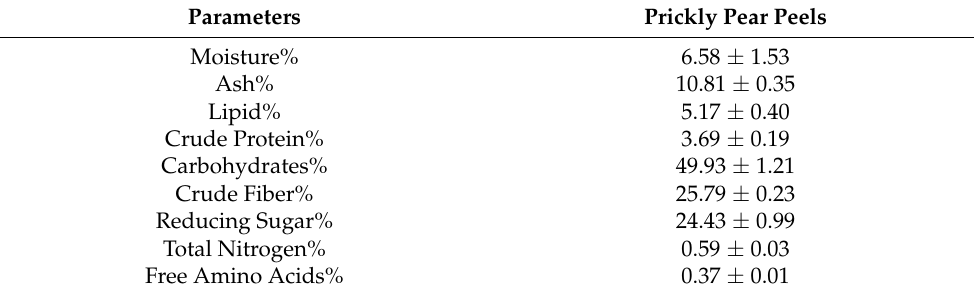
Table 2. Proximate analysis of prickly pear peel